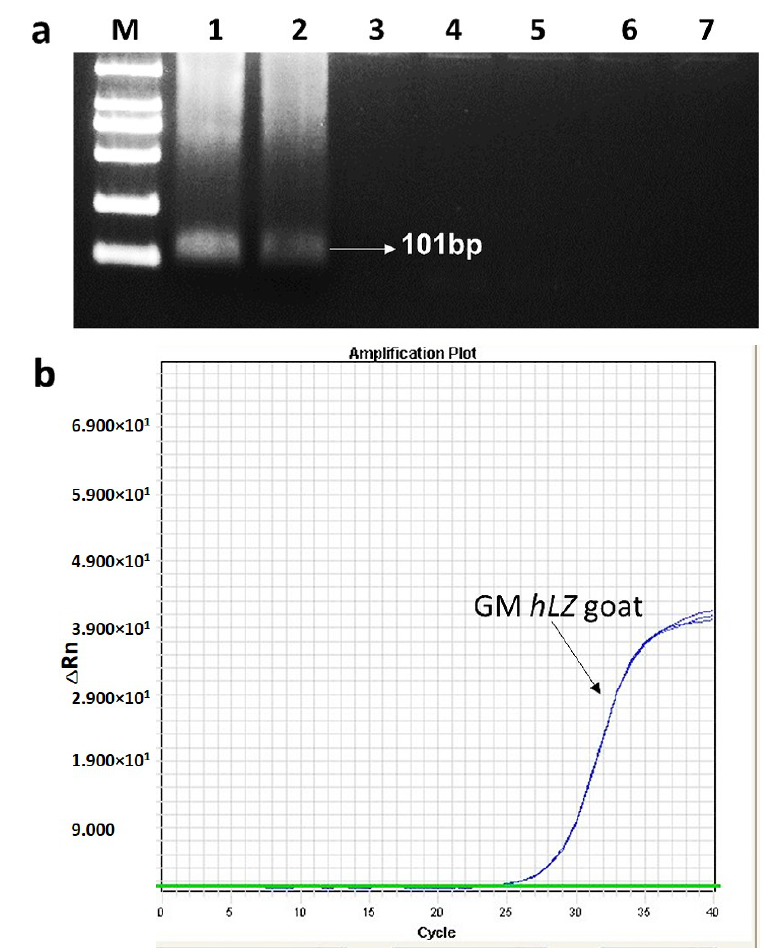
Figure 2. Specificity of the designed event-specific primer/probe set in conventional PCR and real-time PCR. ( a ) Agarose gel electrophoresis of conventional PCR. Lane M, DL2000 markers; lane 1–7, GM hLZ, GM hLZ, GM hLA , GM hLF , GM hLF , GM hSA , GM hSA , and non-GM goat lines. ( b ) Amplification curves of genomic DNA samples from GM hLZ, GM hLF , GM hSA , and non-GM goat